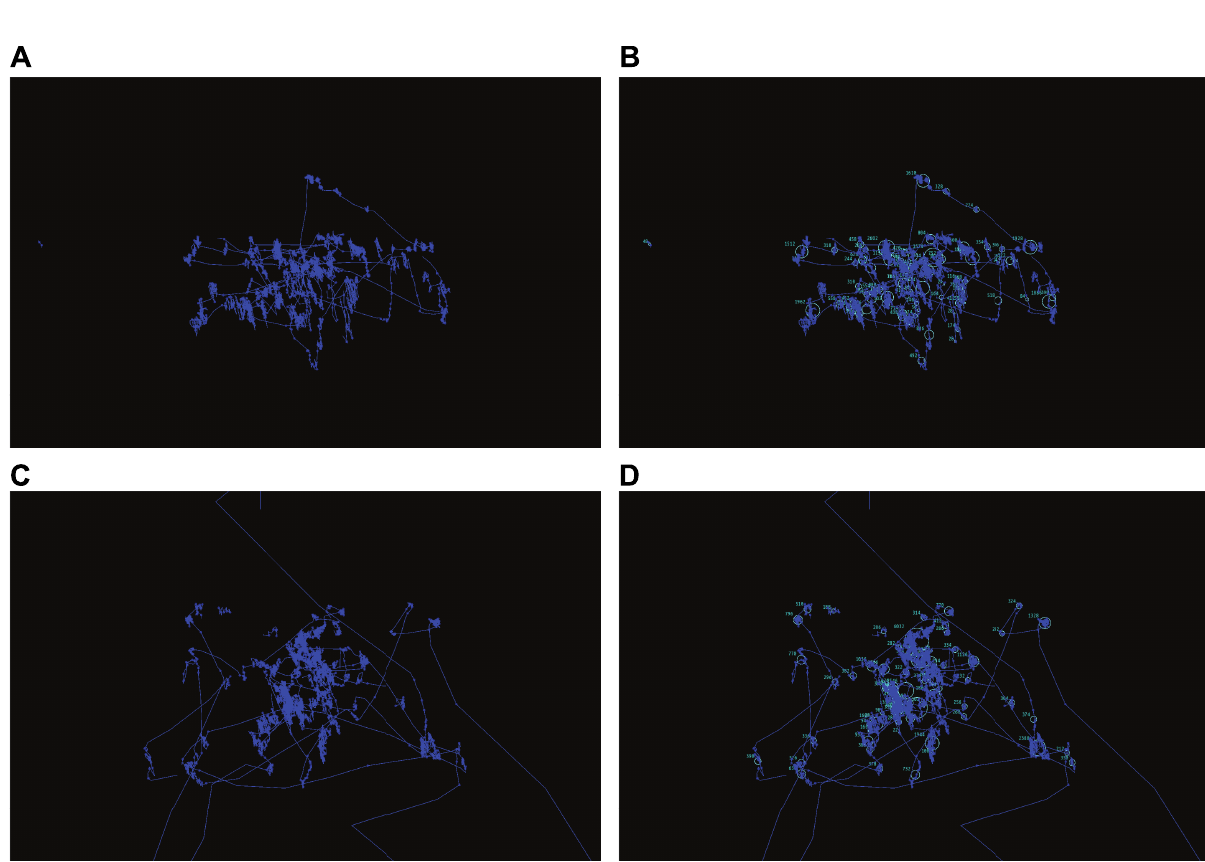
Fig 4. Sample level gaze data. Participant gaze data from two different trials (A,B and C,D) are shown. Gaze positions in screen coordinates are shown in A and C. Fixation durations are indicated numerically next to Eyelink identified parsed fixations which are shown as light blue circles in B and D.